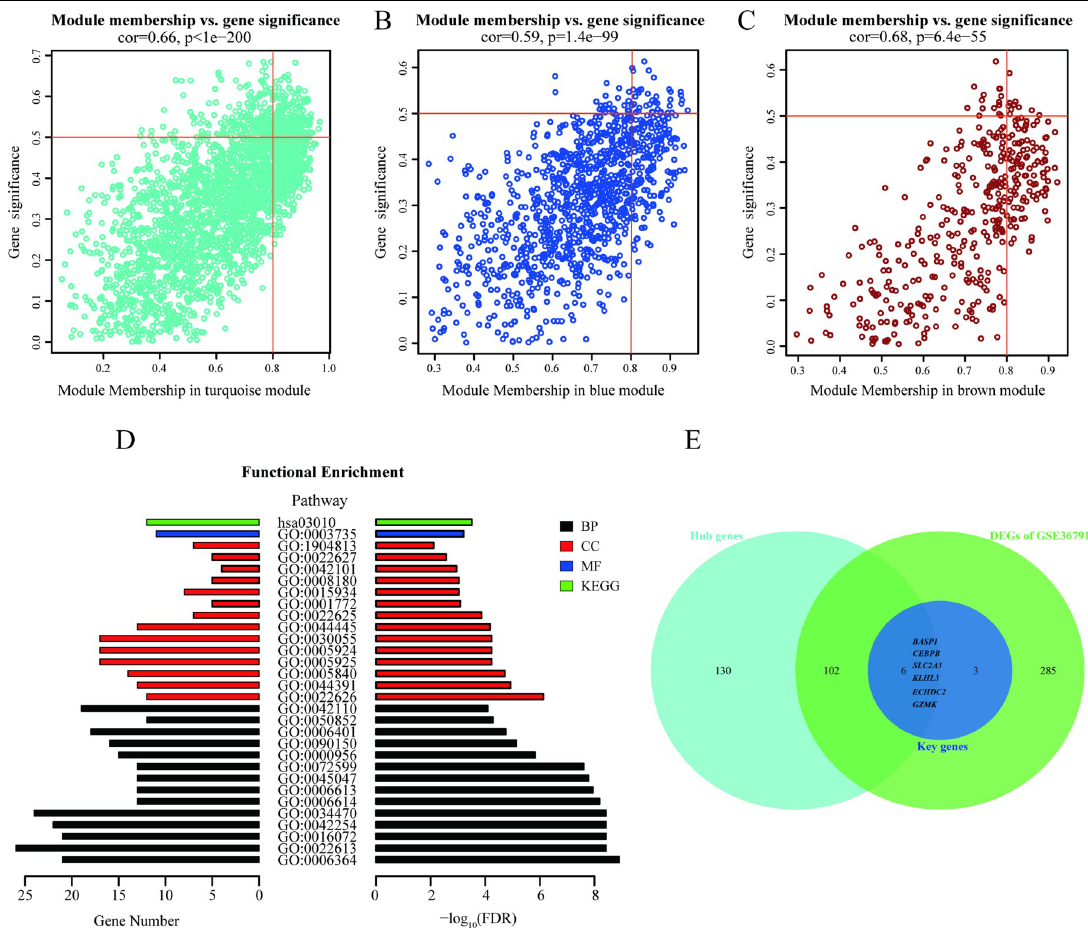
Fig 4. Detection and functional analysis of hub genes. Scatterplots were generated to depict correlations between module membership and gene significance values for the turquoise (A), blue (B), and brown (C) modules. Highly significant correlations were observed between gene significance and module membership in each of these three modules. (D) GO and KEGG annotations of the hub genes were performed. GO terms and KEGG pathways with threshold values of FDR < 0.05 were considered significant and are labeled as follows: BP (biological process) in black; CC (cellular component) in red; MF (molecular function) in blue; and KEGG (Kyoto Encyclopedia of Genes and Genomes) in green. (E) A Venn diagram displays the six common genes among the hub genes, key genes, and DEGs. Thus, these six genes are considered candidate